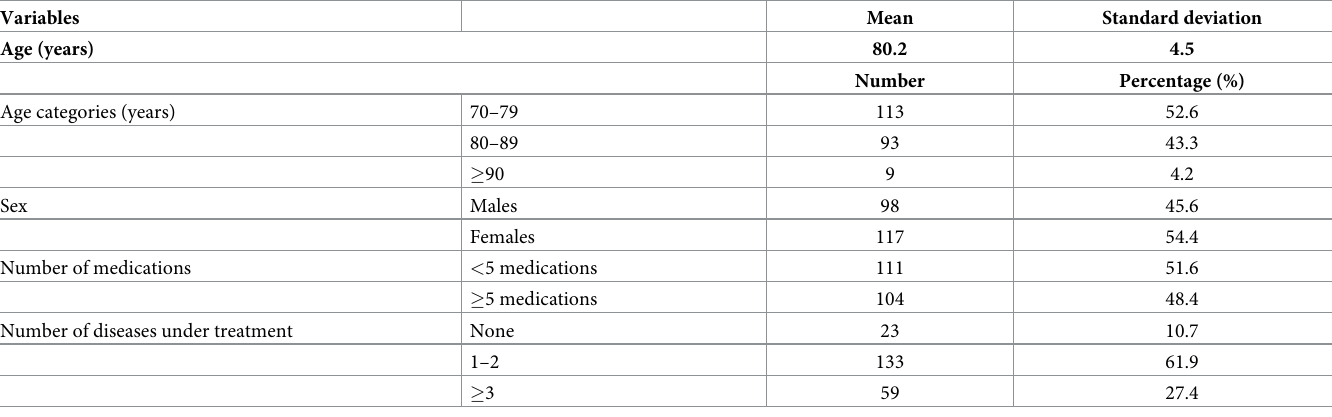
Table 1. Characteristics of the study participants.